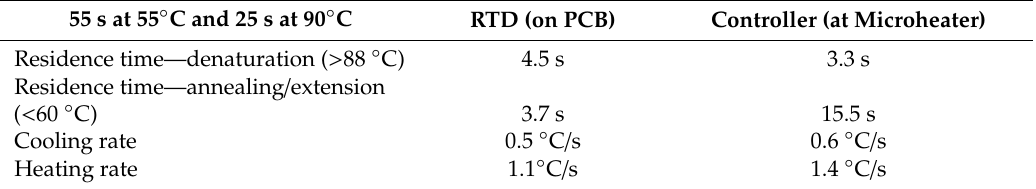
Figure 4. Graphical representation of the temperature measured while running an actual 2T thermocycling experiment with a thick PCB microheater chip. The protocol followed by the temperature controller was 25 s at 90 ◦ C followed by 55 s at 55 ◦ C (blue line). The temperature of the microheaters, as obtained from their resistance values acquired by the temperature controller, and the temperature recorded by the resistance temperature detector (RTD), are also shown. The dashed lines correspond to 88 ◦ C and 60 ◦ C accordingly. Table 1. Residence time and ramping rates for the thick printed circuit board (PCB) microheater chip .